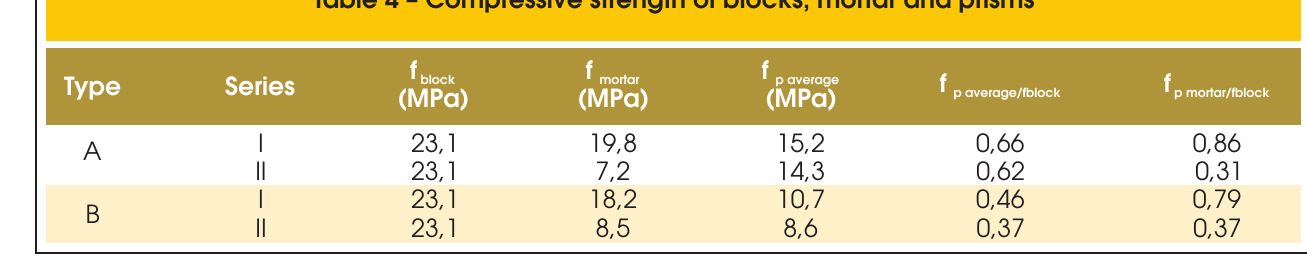
Table 4 – Compressive strength of blocks, mortar and